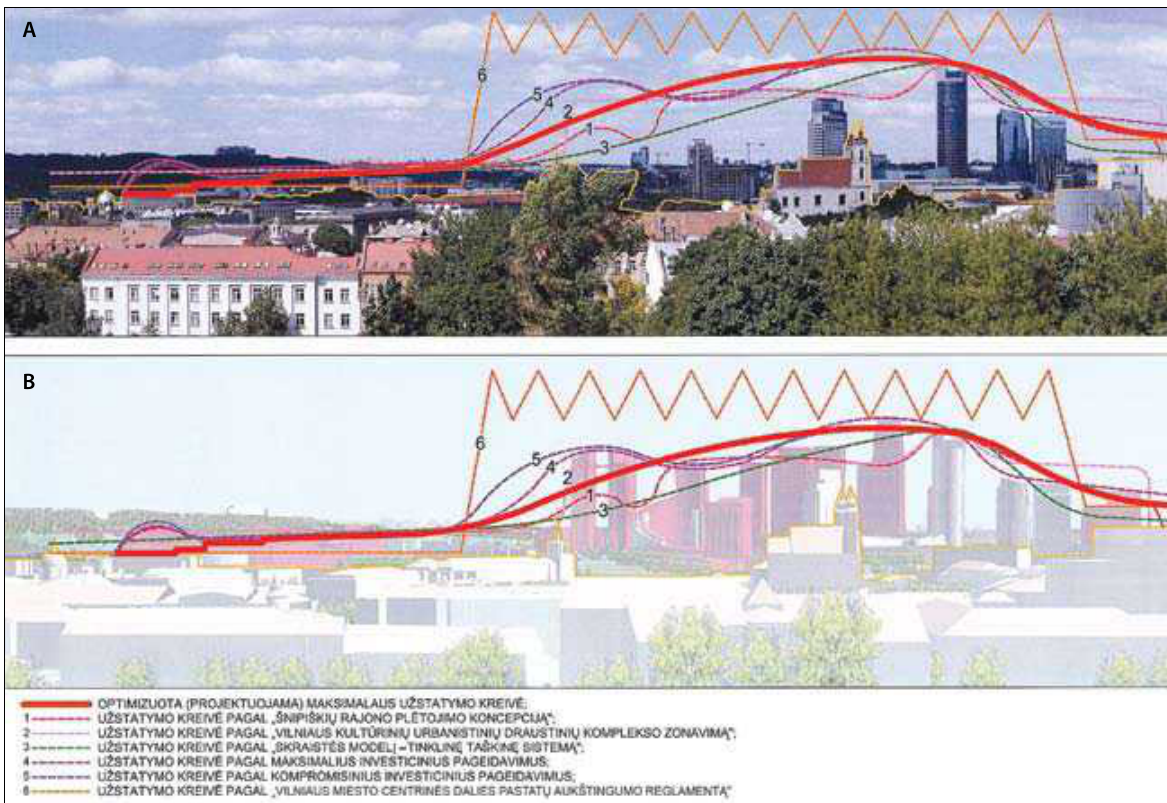
Fig. 10. alternatives for construction height: a – existing situation; b – planned